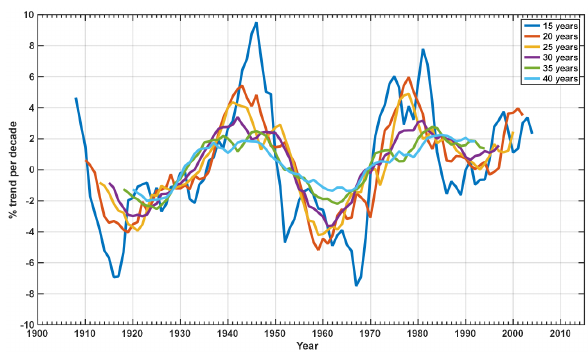
Figure 4. Trends in SSR (%decade − 1 ) calculated for different slid- ing time windows. The value of the trend was calculated at the cen- tral year of each time window.